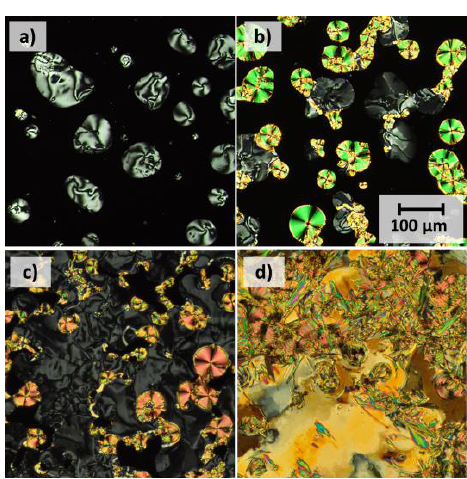
Figure 2. POM of Th 3 (10) showing schlieren ( a ) and focal-conic ( b ) textures of the SmC phase at 93.5 ◦ C, modified textures of the SmF phase at 91.5 ◦ C ( c ), and changes upon cooling to the crystalline phase at 65.0 ◦ C ( d ).